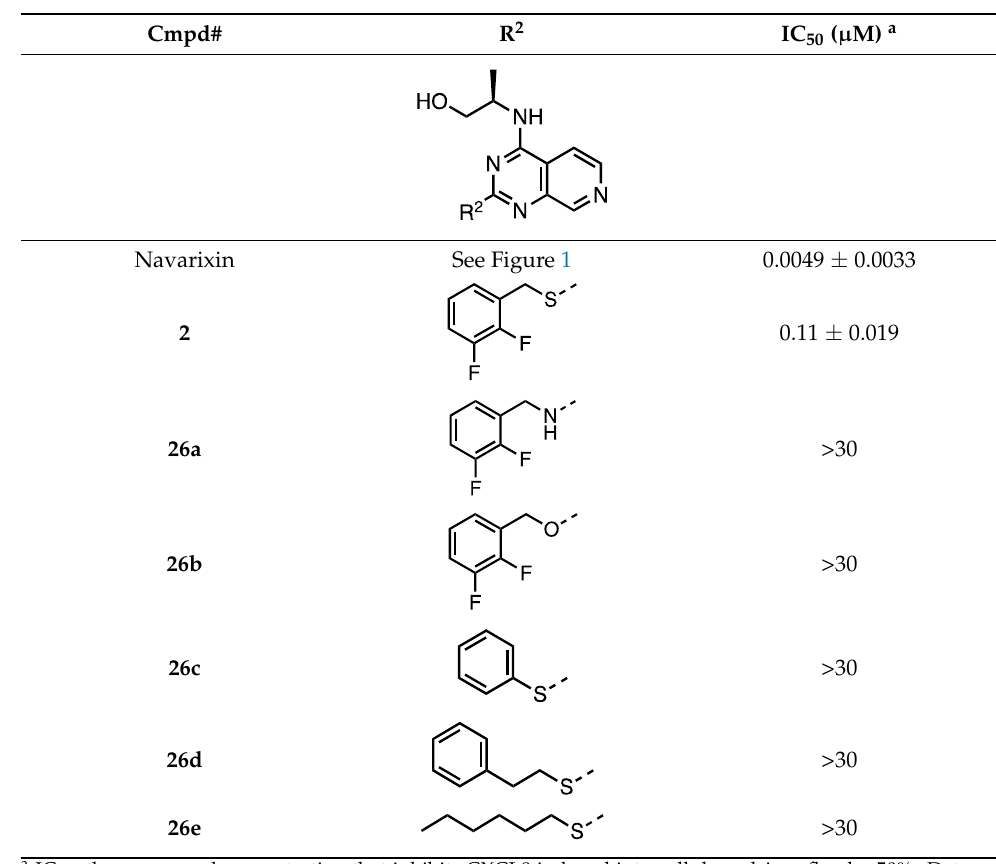
Table 3. CXCR2 antagonism of 2-substituted pyrido[3,4- d